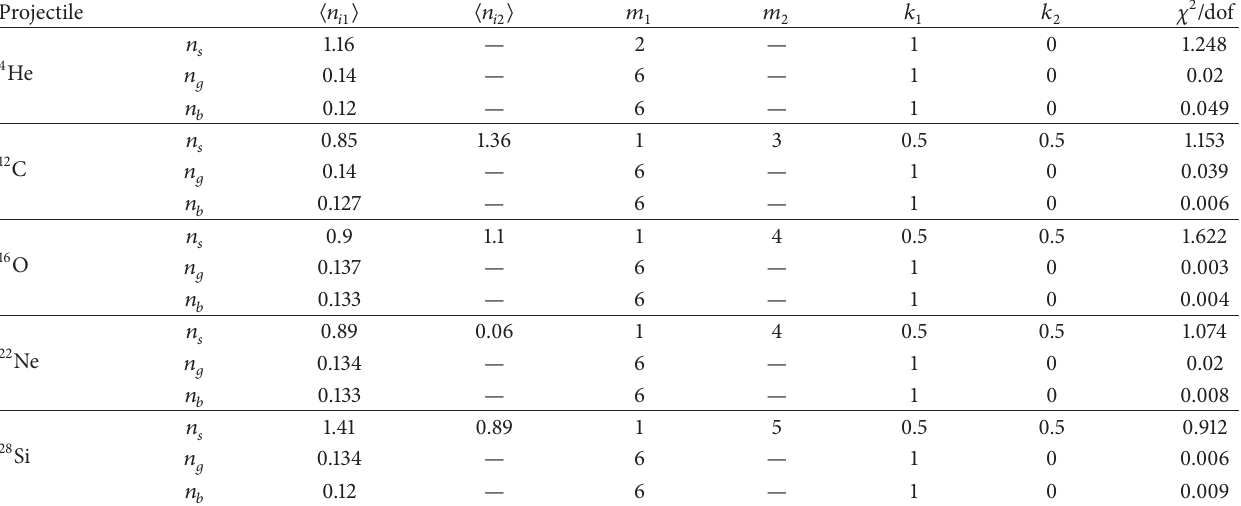
Table 3: Parameter values for multiplicity distributions for shower, grey, and black particles. The values of ⟨𝑛 𝑖1 ⟩ , ⟨𝑛 𝑖2 ⟩ , 𝑚 1 , 𝑚 2 , and 𝑘 1 , 𝑘 2 for 4 He-, 12 C-, 16 O-, and 28 Si-H at 4.5 AGeV/c and 22 Ne-H at 4.1AGeV/c.